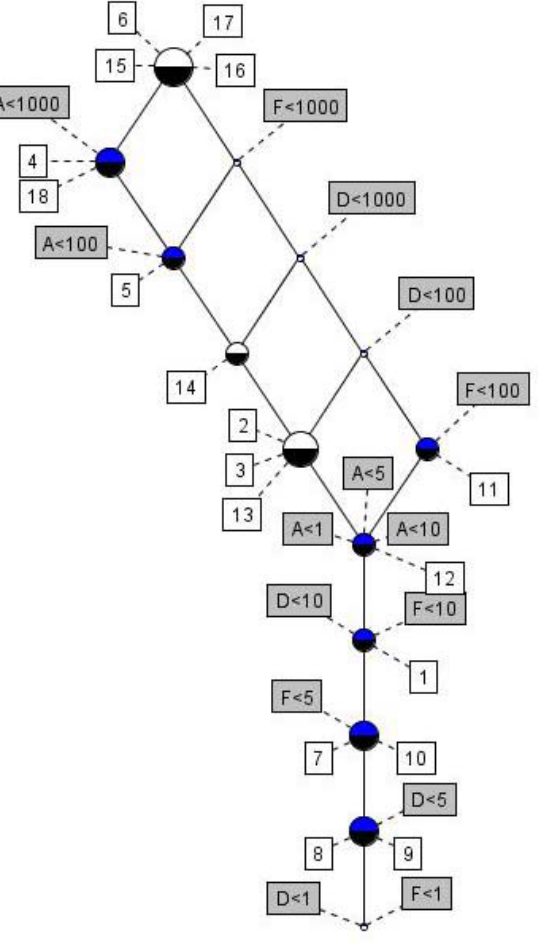
Figure 2 . Lattice line diagram for ecotoxicological effects by 1,1-dimethylhydrazine and its transformation products as derived by EcoSAR